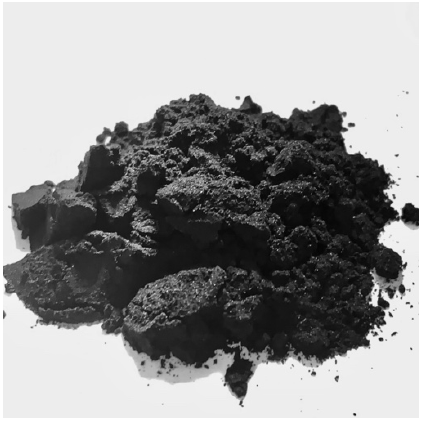
Figure 2. Overview photo of the Activated Carbon used in the study.